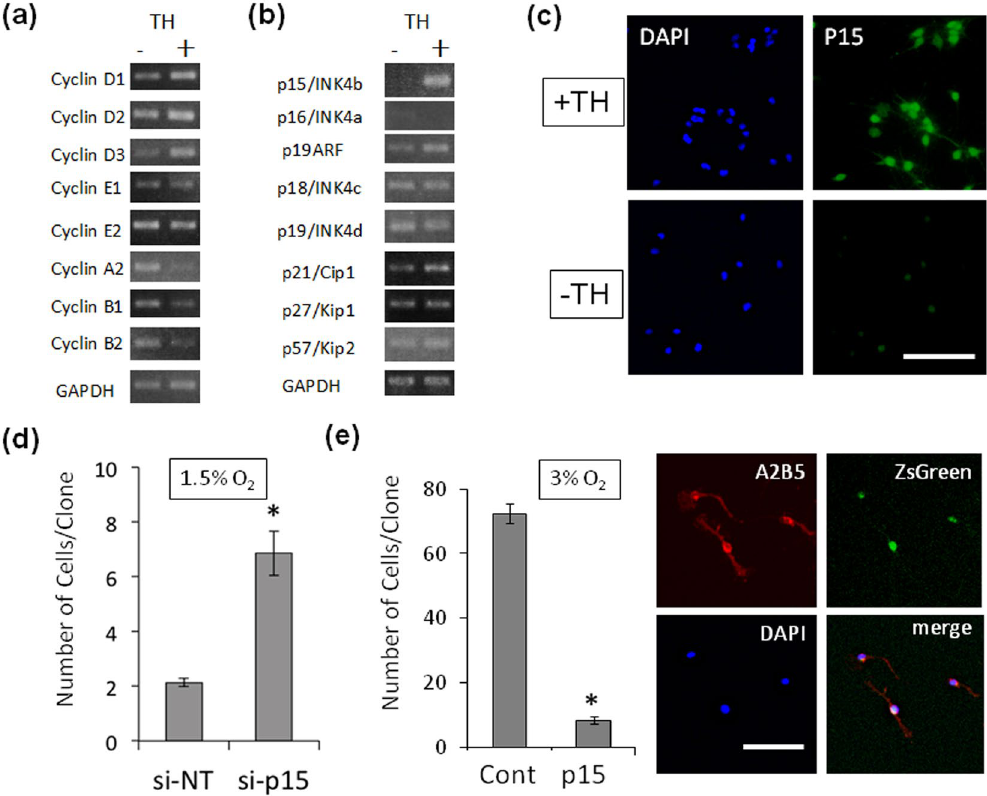
Figure 4. An increase in p15/INK4b in hypoxic OPCs in culture helps mediate the TH-dependent G1 arrest of OPCs. ( a and b ) P7 OPCs were cultured in 1.5% O 2 in PDGF, with or without TH, for 15 days, and assayed by RT-PCR. GAPDH was used as an internal control. ( a ) In Cyclin genes, TH decreased the mRNA for G2/M Cyclins A2, B1 and B2. ( b ) In CKI genes, TH strongly increased the mRNA for p15/INK4b. ( c ) P7 OPCs were cultured in PDGF without TH for 10 days in 1.5% O 2 , and then TH was added to some cultures ( + TH) but not to others ( − TH) for 2 days. The cells were then labeled with rabbit anti-p15/INK4b antibodies ( green ) and DAPI ( blue ). Note that p15/INK4b protein increased in the nucleus of the TH-treated cells. Scale bar: 100 μ m. ( d ) P7 OPCs cultured in 3% O 2 in PDGF without TH for 12 days were co-transfected with anti-p15/INK4b siRNA (si-p15) and GFP expressing transfection-reporter plasmid DNA (pMaxGFP); a non-targeting siRNA pool (si- NT) served as a negative control. Cells were re-cultured at clonal-density in 1.5% O 2 , PDGF and TH for another 5 days. The number of GFP + cells in each clone was counted. Note that the anti-p15/INK4b siRNA prevented the deceleration of cell cycle that occurs in 1.5% O 2 in the presence of TH. * P < 0.001 (unpaired Student’s t - test, n = 3). ( e ) Freshly prepared P7 OPCs were infected with either a p15/INK4b-IRES-ZsGreen expressing retrovirus vector (p15) or the ZsGreen expressing empty vector as a negative control (Cont), and the cells were cultured at clonal-density in 3% O 2 and PDGF without TH for 7 days. The number of ZsGreen + cells in each clone was counted, and the results are shown in the graph on left. Note that the cells over expressing p15/INK4b proliferated much less than control. * P < 0.001 (unpaired Student’s t -test, n = 3). The p15/INK4b-IRES-ZsGreen expressing cells were also labeled with A2B5 antibody ( red ) and DAPI ( blue ); as shown in the panels on right, the ZsGreen + OPCs ( green ) are bipolar and A2B5 + . Scale bar: 100 μ